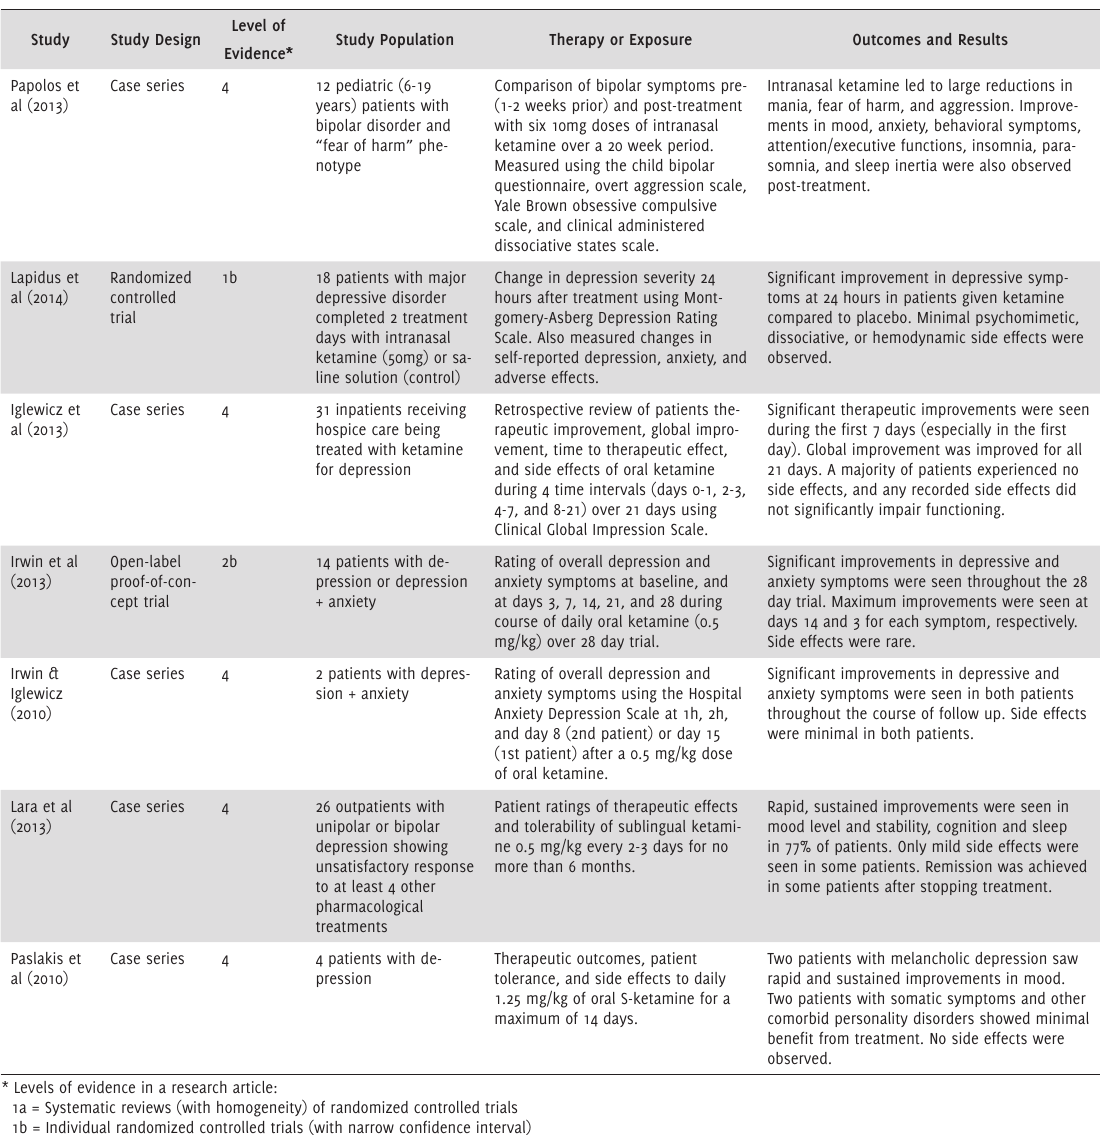
Table 1. Studies Evaluating Intranasal/Oral Ketamine in Treatment-Resistant